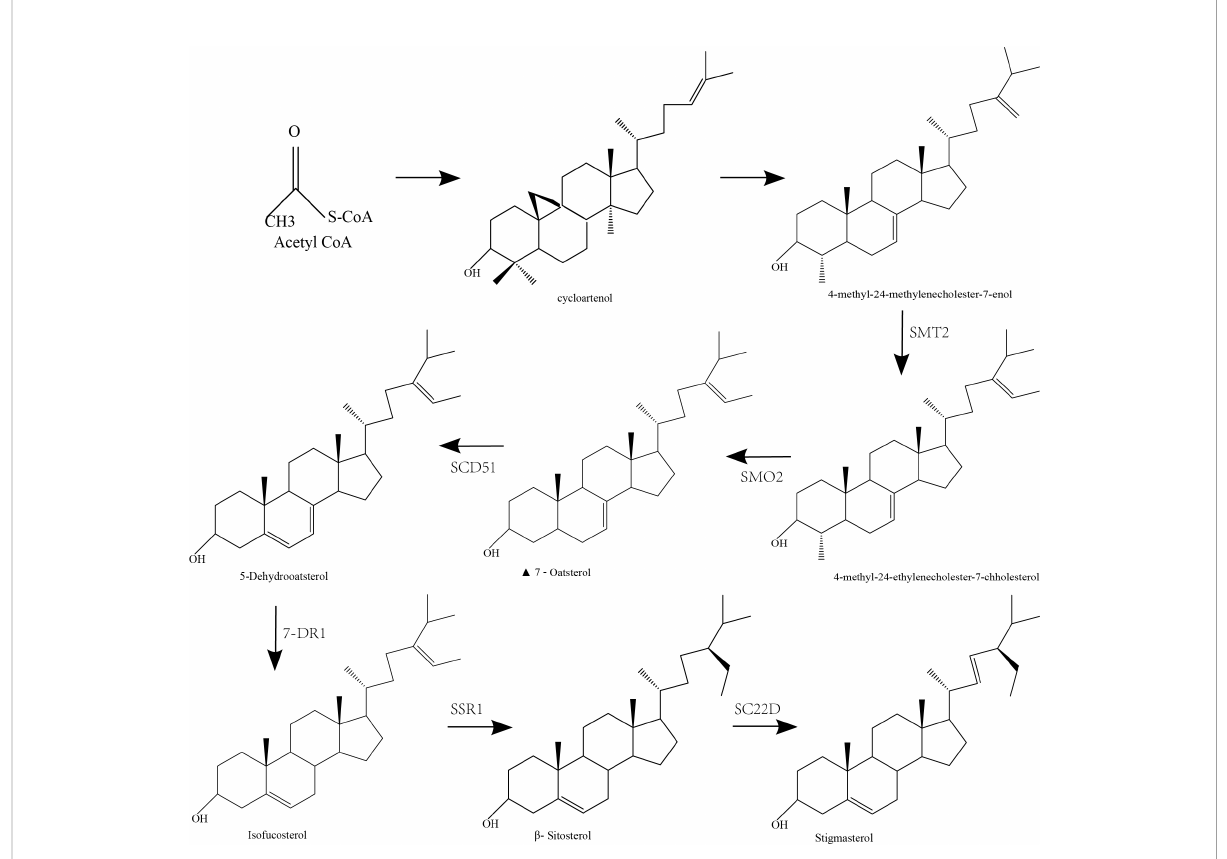
FIGURE 2 The biosynthetic pathway of